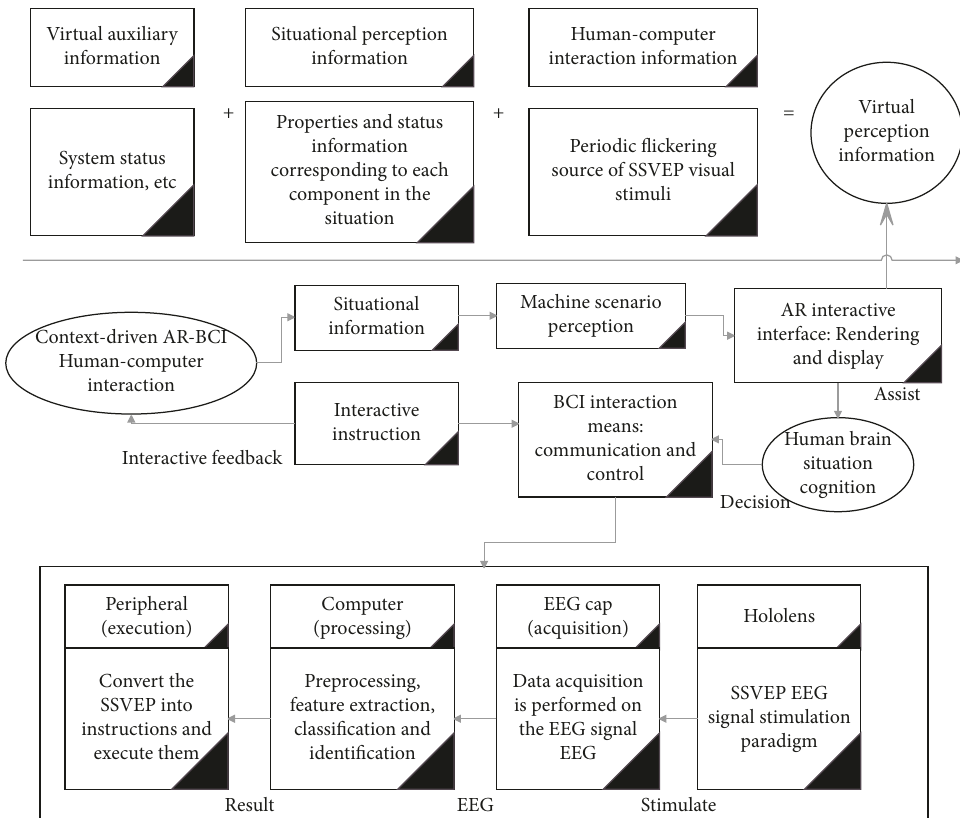
Figure 7: Schematic diagram of the brain-computer fusion interactive